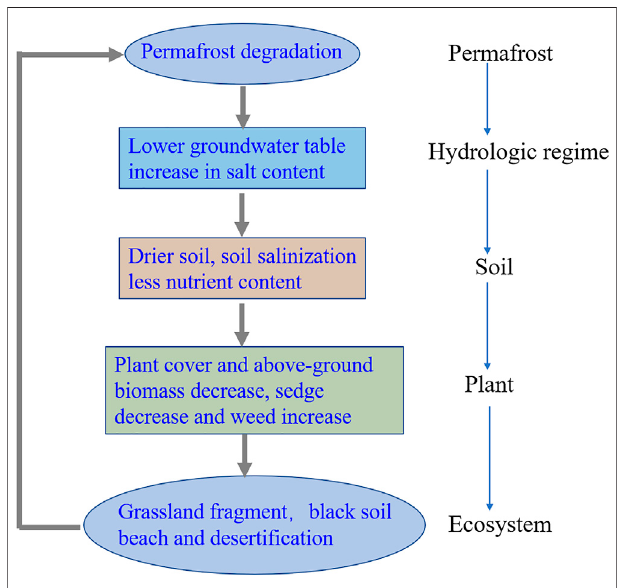
FIGURE 4 | Interactions between permafrost degradation and vegetationdegradationintheHeadwater AreaofYellowRiveronnortheastern Qinghai-Tibet Plateau, Southwest